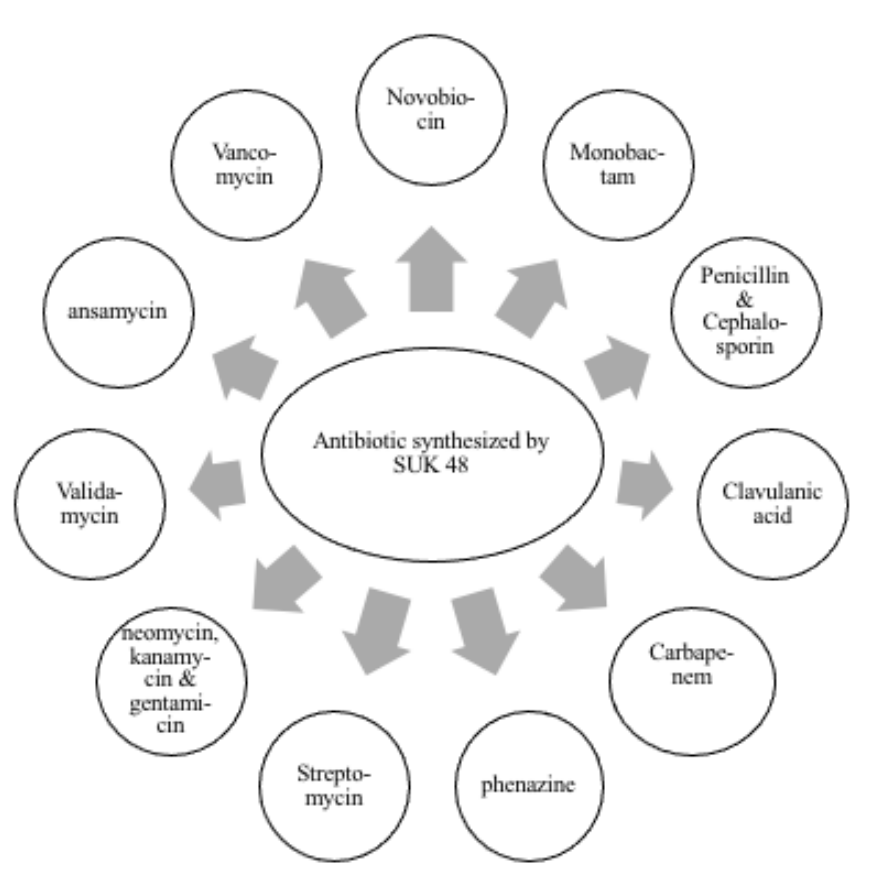
Figure 3. List of antibiotic biosynthesis pathways by Streptomyces SUK 48.